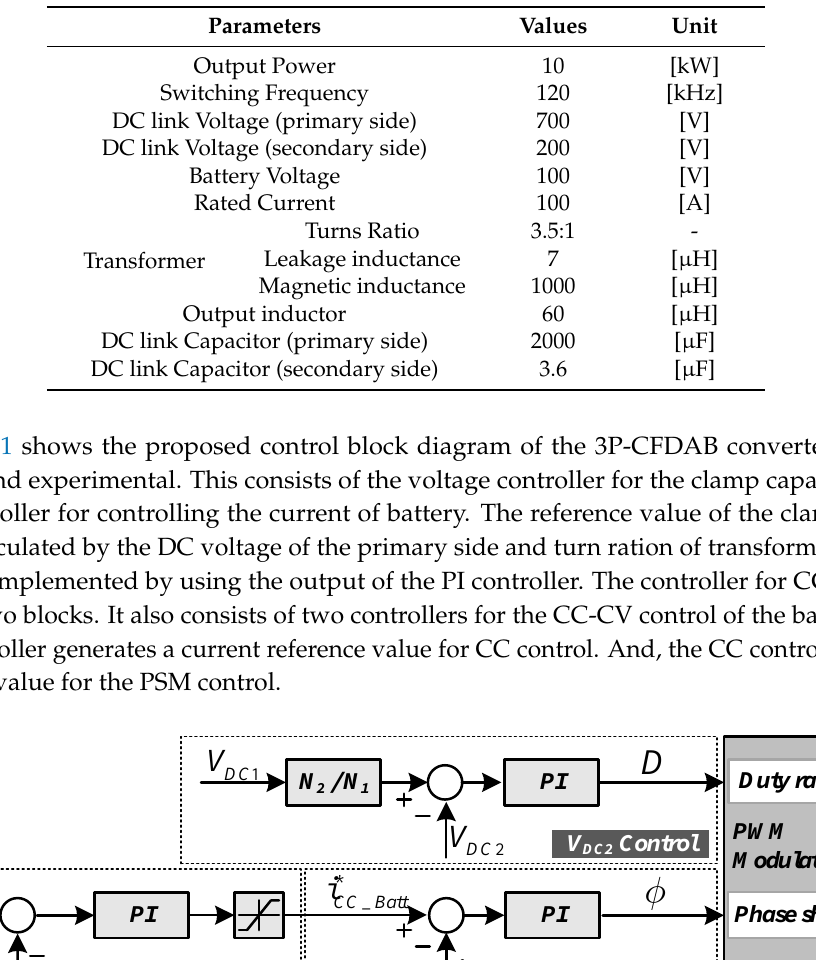
Table 6. Simulation parameters of the CF-TPDAB converter.